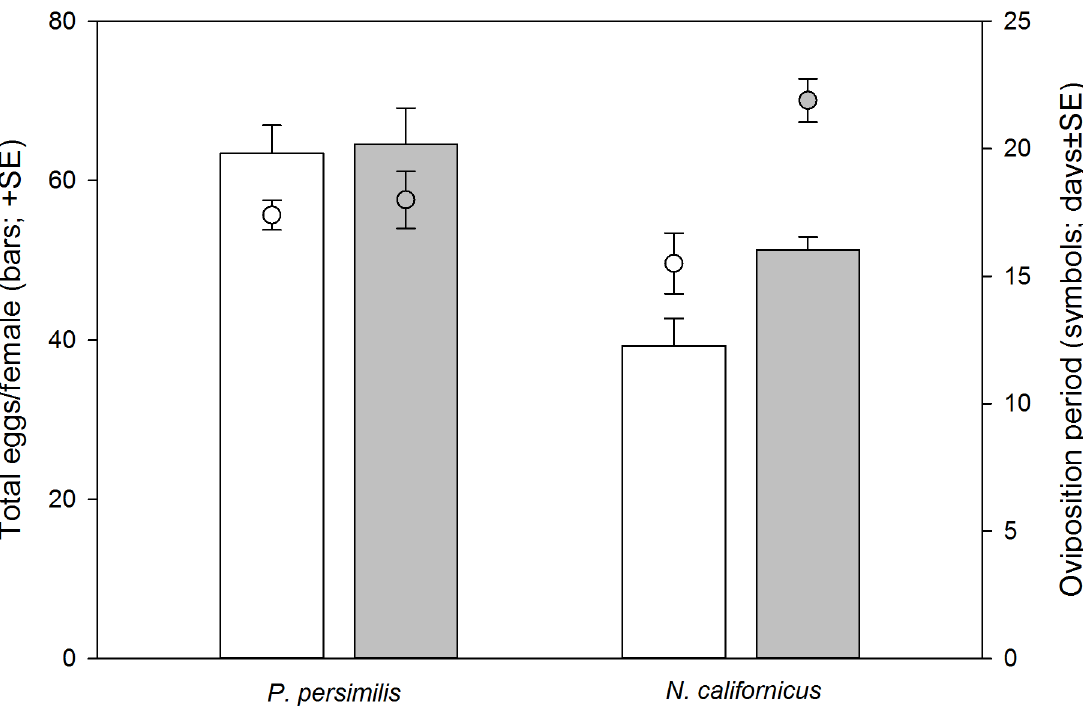
Fig 4. Oviposition. Total number of eggs produced (bars) and oviposition period (symbols) of singly and multiply mated females of P . persimilis (N = 30) and N . californicus (N = 23). GLM for total number of eggs produced: species ( Wald ӽ 2 = 51.710, P < 0.001), single/multiple mating ( Wald ӽ 2 = 8.332, P = 0.004), species * single/multiple mating ( Wald ӽ 2 = 6.363, P = 0.012). GLM for oviposition days: species ( Wald ӽ 2 = 0.610, P = 0.435), single/multiple mating ( Wald ӽ 2 = 13.622, P < 0.001), species * single/multiple mating ( Wald ӽ 2 = 9.187, P = 0.002).